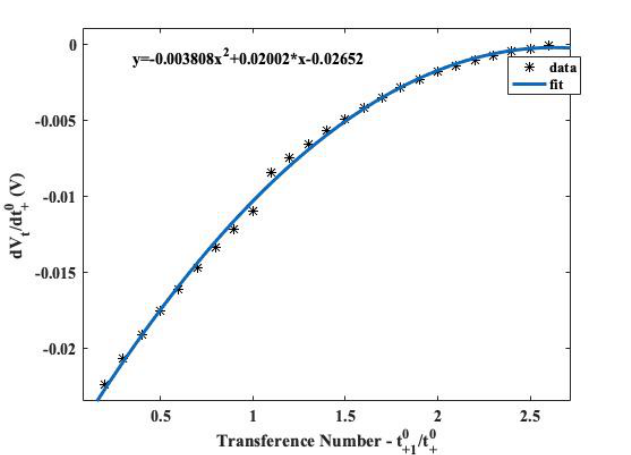
Figure 13. Change of terminal voltage to transference number vs. transference